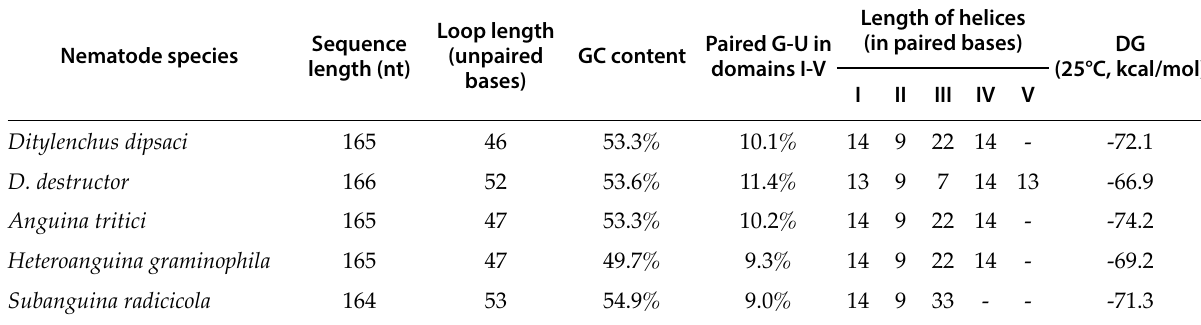
Table 3. Statistics of the secondary structures (D3-LSU rRNA) proposed in this study. Nematode species